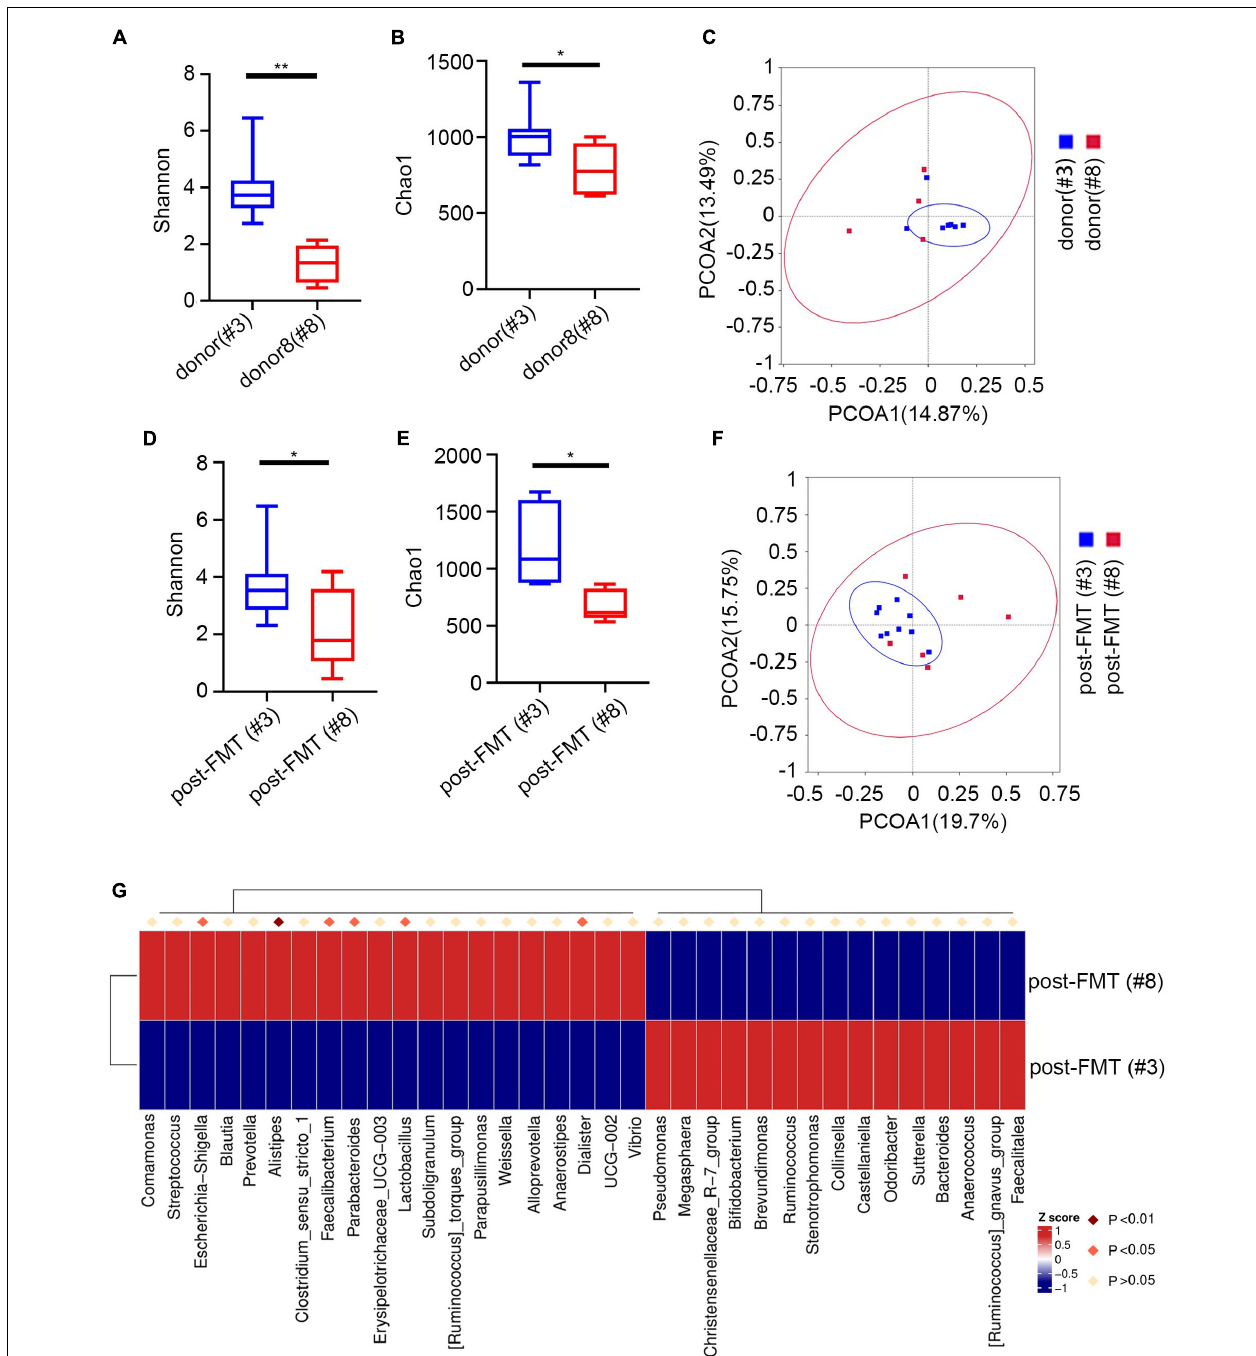
FIGURE 6 | IgA-targeting of microbiota post-FMT is influenced by donor microbiota. (A) Shannon index of different donors. (B) Chao1 index of different donors. (C) PcoA index of different donors. (D) Shannon index of patients post FMT by different donor. (E) Chao1 index of patients post FMT by different donors. (F) PcoA index of patients post FMT by different donor. (G) Heatmap analysis of patients post FMT by different donors by Metastat. * p < 0.05, ** p <